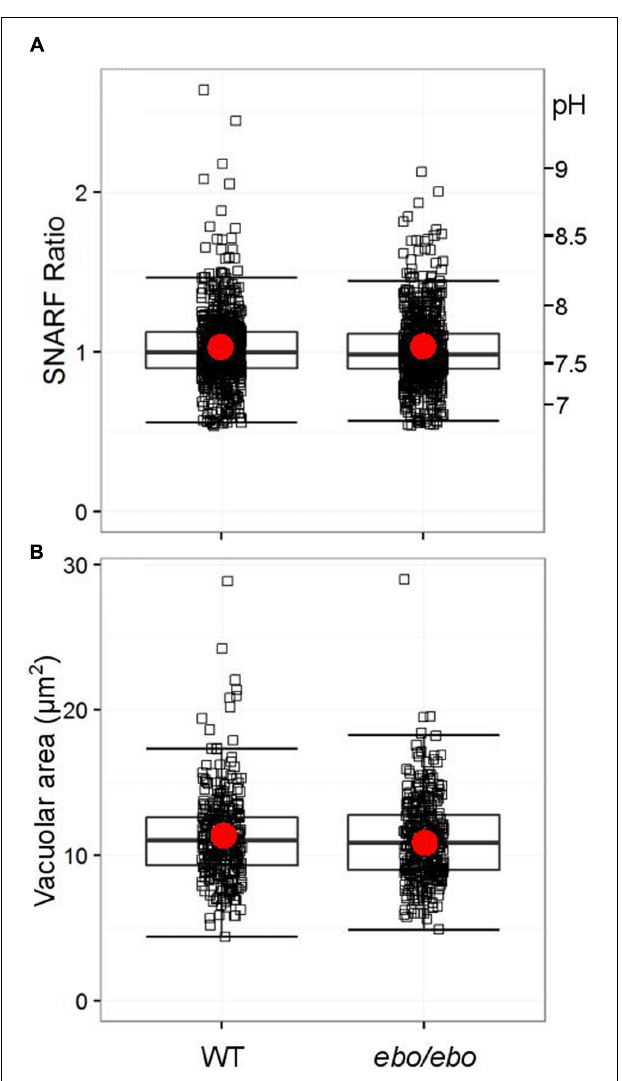
FIGURE 9 | Tamoxifen does not counteract the oxidase-driven alkalinization and swelling of the vacuole. (A) Distribution SNARF fluorescence ratios measured in a minimum of 700 fully phagocytosed SNARF-labeled Candida by human neutrophils. Fluorescence ratios are indicated on the left-hand side, a corresponding pH scale is provided on the right-hand side (see Materials and Methods for calibration of SNARF fluorescence ratio to pH). (B) Distribution of areas measured in a minimum of 340 individual vacuoles incorporating a single Candida . Boxes show medians and interquartile ranges of data, compiled from three independent experiments. Red circles locate the mean values, the asterisk locating the mean for DPI denotes statistical significance from the control p < 0.05.